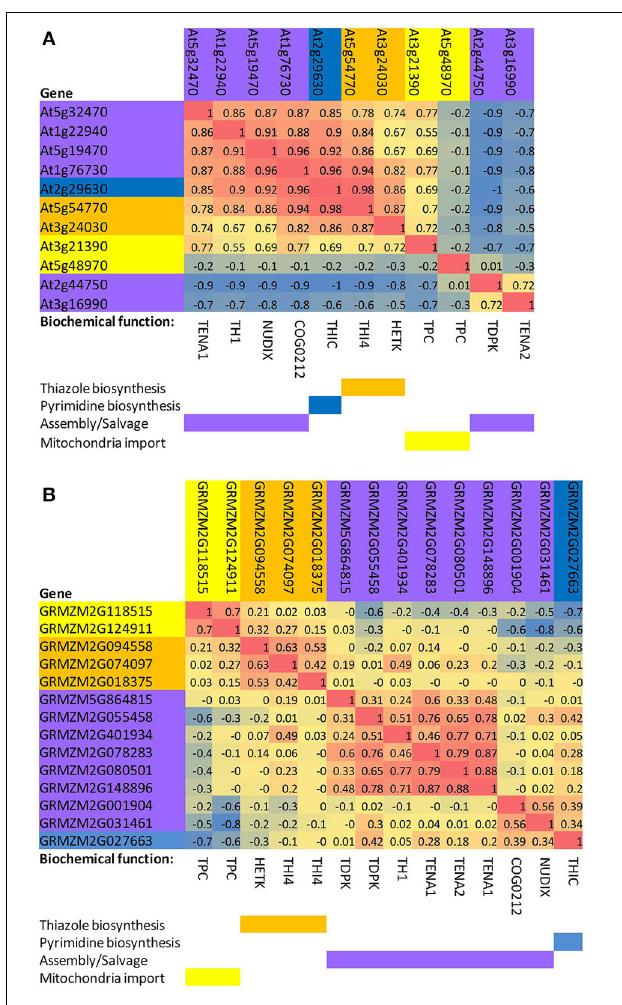
FIGURE 2 | Correlated expression of thiazole, pyrimidine, transport, and salvage genes of the thiamin biosynthesis pathway in Arabidopsis and maize. (A) Arabidopsis . A profile for each gene was calculated based on Pearson rank-order correlations with other thiamin pathway genes in the AtGeneExpress development dataset (Schmid et al., 2005). Genes were then clustered based on the matrix of pairwise correlations (R2 values) among the gene profiles. (B) Maize. A profile for each gene was constructed by calculating Pearson rank-order correlations with other thiamin pathway genes in the QTELLER transcriptome dataset (see Methods). Genes were then clustered based on the matrix of pairwise correlations (R2 values) among the gene profiles. TPC, mitochondrial thiamin diphosphate transporter; THI4, thiazole biosynthesis protein; HETK, hydroxyethyl thiazole kinase;. TDPK, thiamin diphosphokinase paralogs; TH1, hydroxymethylpyrimidine phosphate kinase/hydroxymethylpyrimidine kinase/thiamin-phosphate pyrophosphorylase, dual function protein; COG0212, putative thiamin related 5-formyltetrahydrofolate cycloligase-like protein, function unknown; TENA1 and TENA2, thiaminase II paralogs; NUDIX, putative thiamin related NUDIX type hydrolase; THIC, hydroxymethylpyrimidine phosphate synthase.